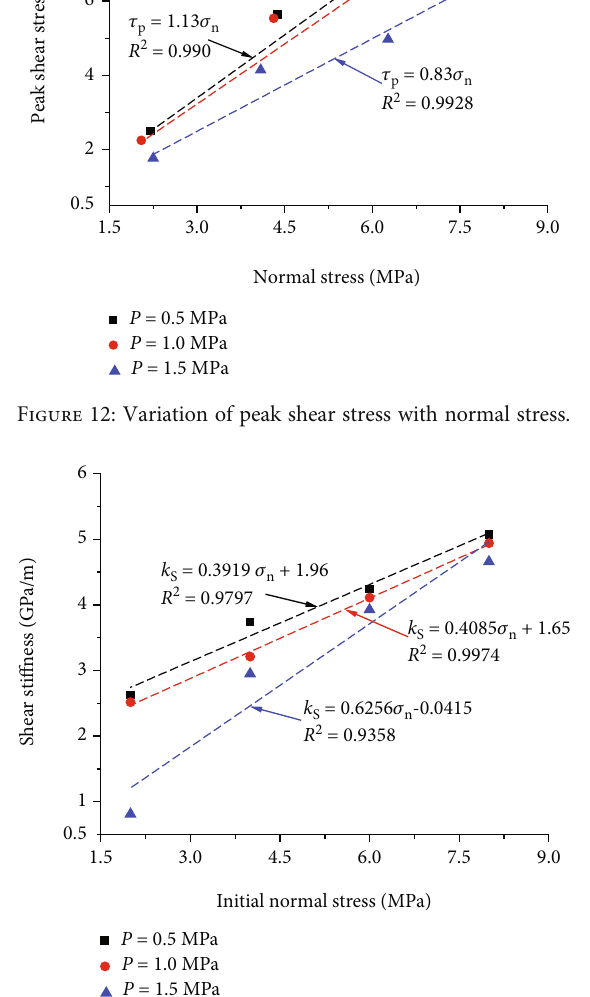
Figure 13: Variation of shear sti ff ness with initial normal stress.